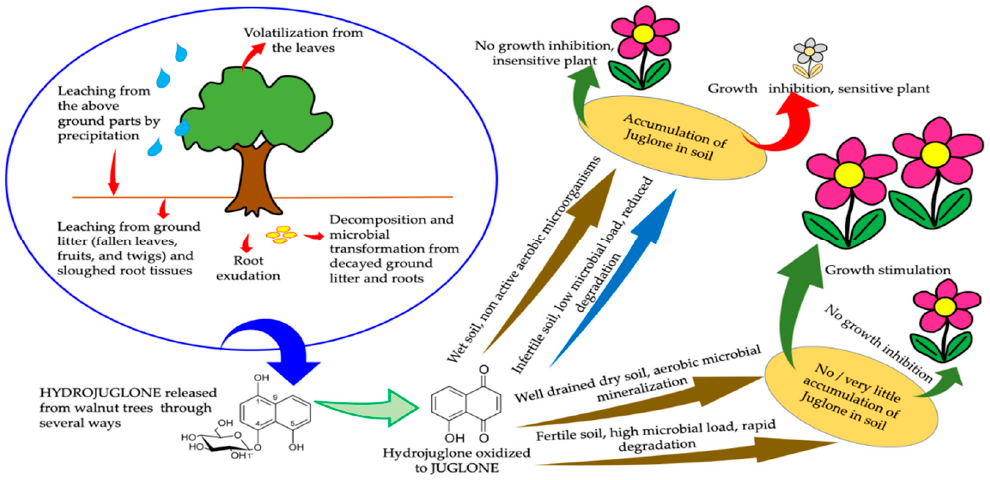
Figure 2. Routes of release, environmental fates, and phytotoxic and biostimulatory effects of juglone.